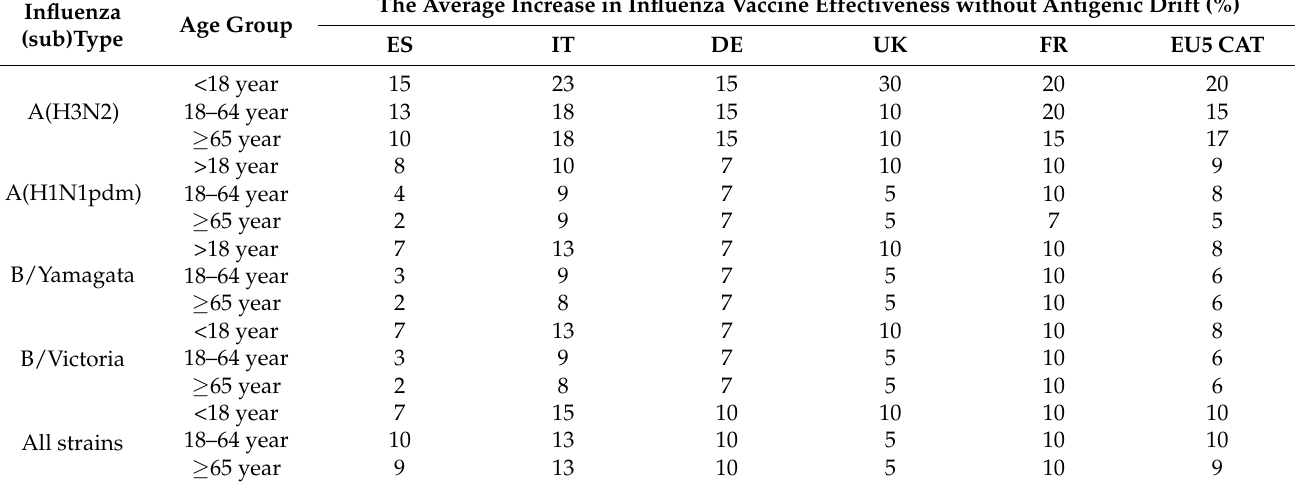
Table A2. Country-level and EU5-level survey responses on the IVE increase without antigenic drift.